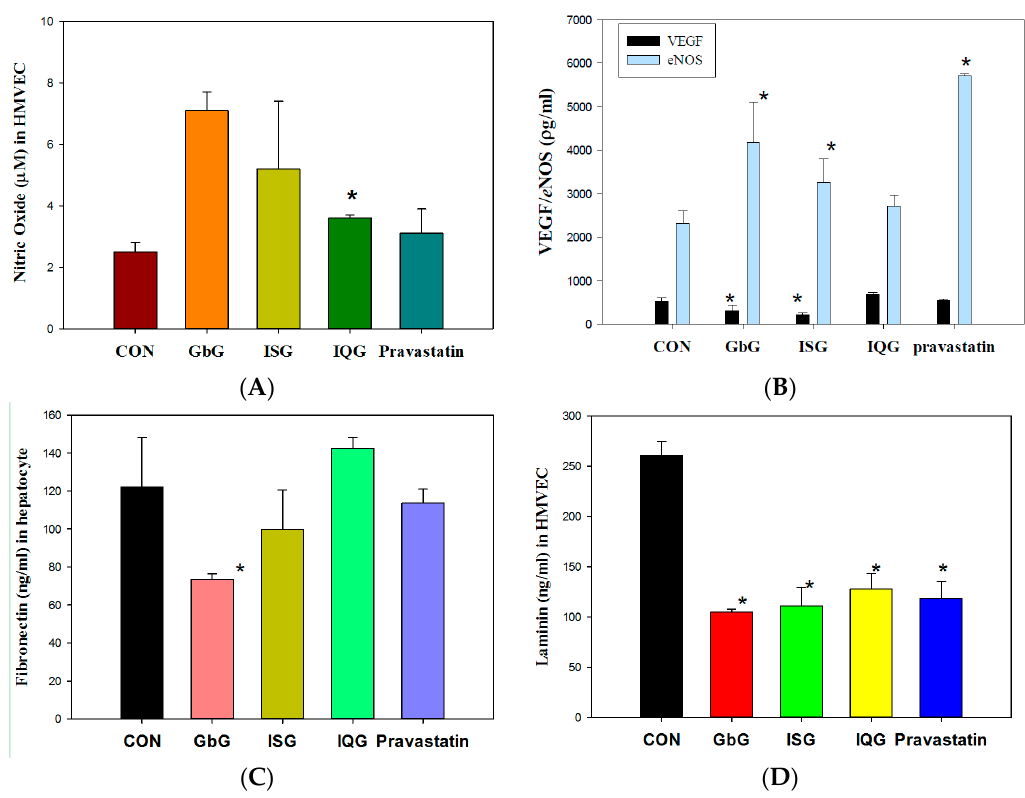
Figure 5. NO bioavailability of ( A ) nitric oxide, ( B ) Endothelial nitric oxide synthase, Endothelial nitric oxide synthase, e NOS and vascular endothelial growth factor, VEGF, ( C ) adhesion of fibronectin in hepatocytes, and ( D ) laminin on human microvascular endothelial cells, HMVEC-diabetic type cells. (* p < 0.05).